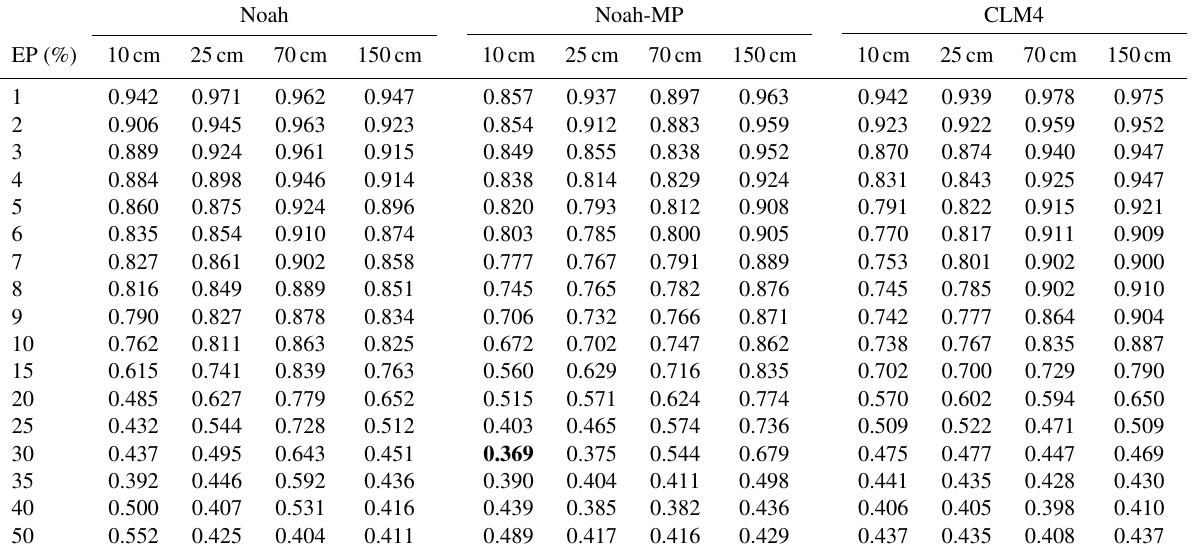
Table 6. Results of Euclidean distances ( d ) between individual points and the optimal point for ROC analysis are listed. The best performance (i.e. lowest d ) for each column (i.e. each soil layer of an LSM scheme) is highlighted. The optimal performance of all is highlighted in bold. EP: exceedance probability.